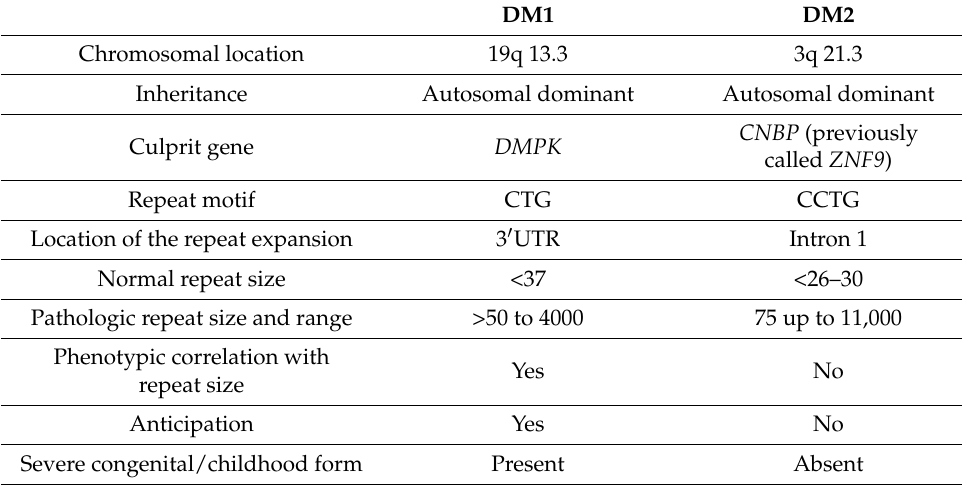
Table 2. Genetics of DM1 versus DM2.